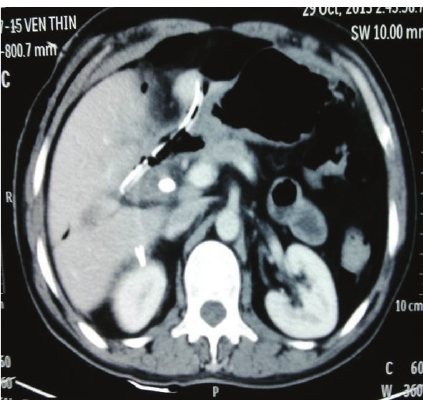
Figure 1: CT scan showing the drain in the 2nd part of duodenum.